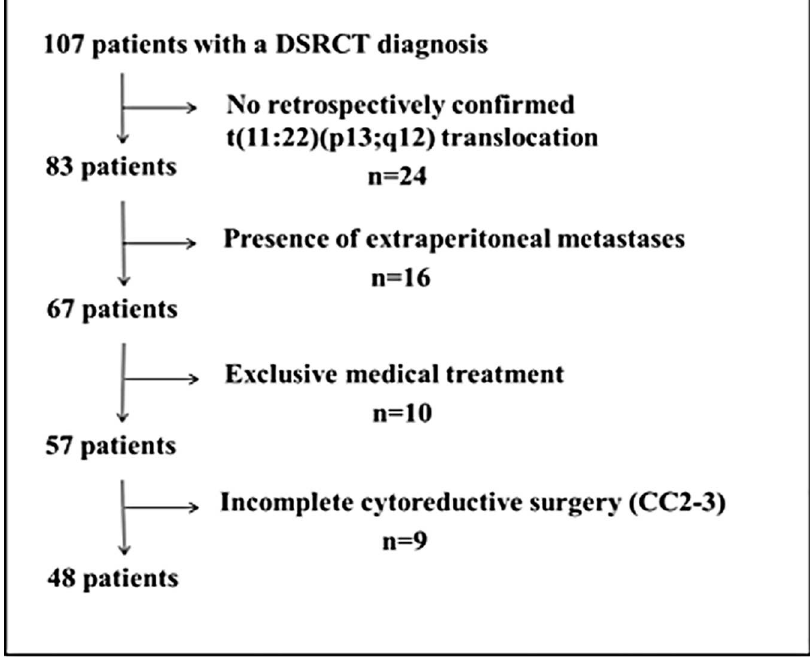
Fig 1. Selection of patients with DSRCT without extra-peritoneal metastases and complete cytoreductive surgery among all the patients with DSRCT.